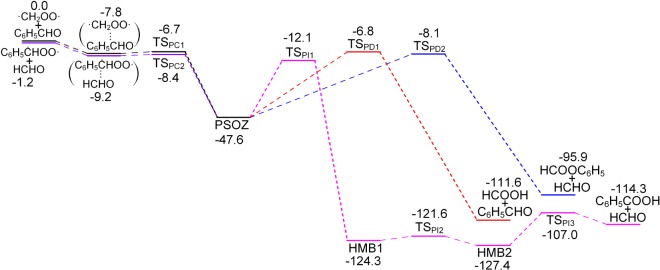
Potential energy surface (kcal mol−1) of the C6H5ĊHOO· + HCHO and ·CH2OO· + C6H5CHO reaction calculated at the CBS-QB3 level.